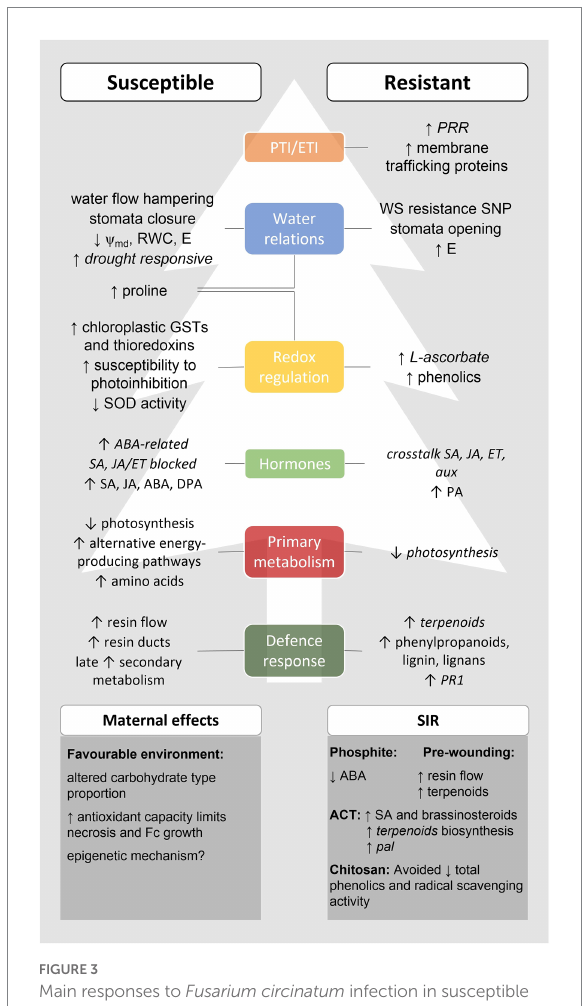
FIGURE 3 Main responses to Fusarium circinatum infection in